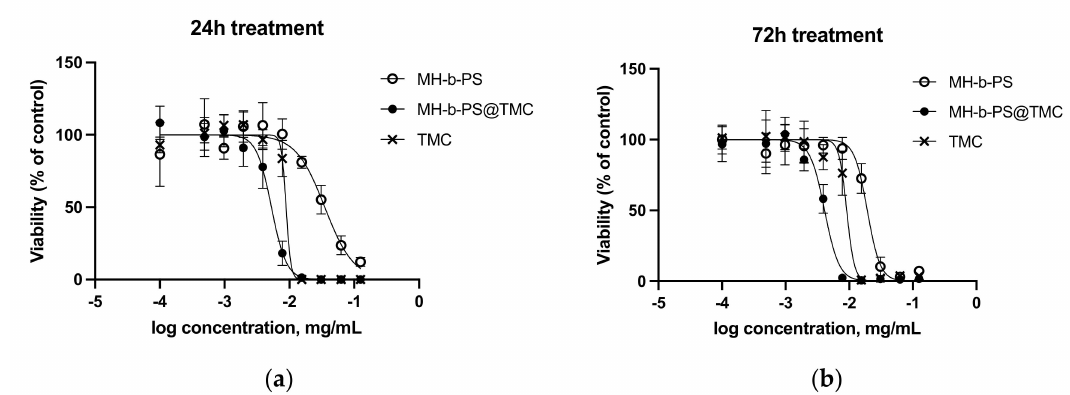
Figure 6. Cytotoxicity for blank MH- b -PS nanoparticles (empty circle), MH- b -PS@TMC (full circle), and TMC solution (cross) on the MCF-7 cell line, as estimated by MTT assay ( a ) after 24 h or ( b ) 72 h of incubation. Table 3. Comparison of IC 50 for blank MH-b-PS nanoparticles, MH-B-PS@TMC, and TMC solution after 24 h or 72 h of application. The data represent mean and 95% confidence interval (CI), n = 6.